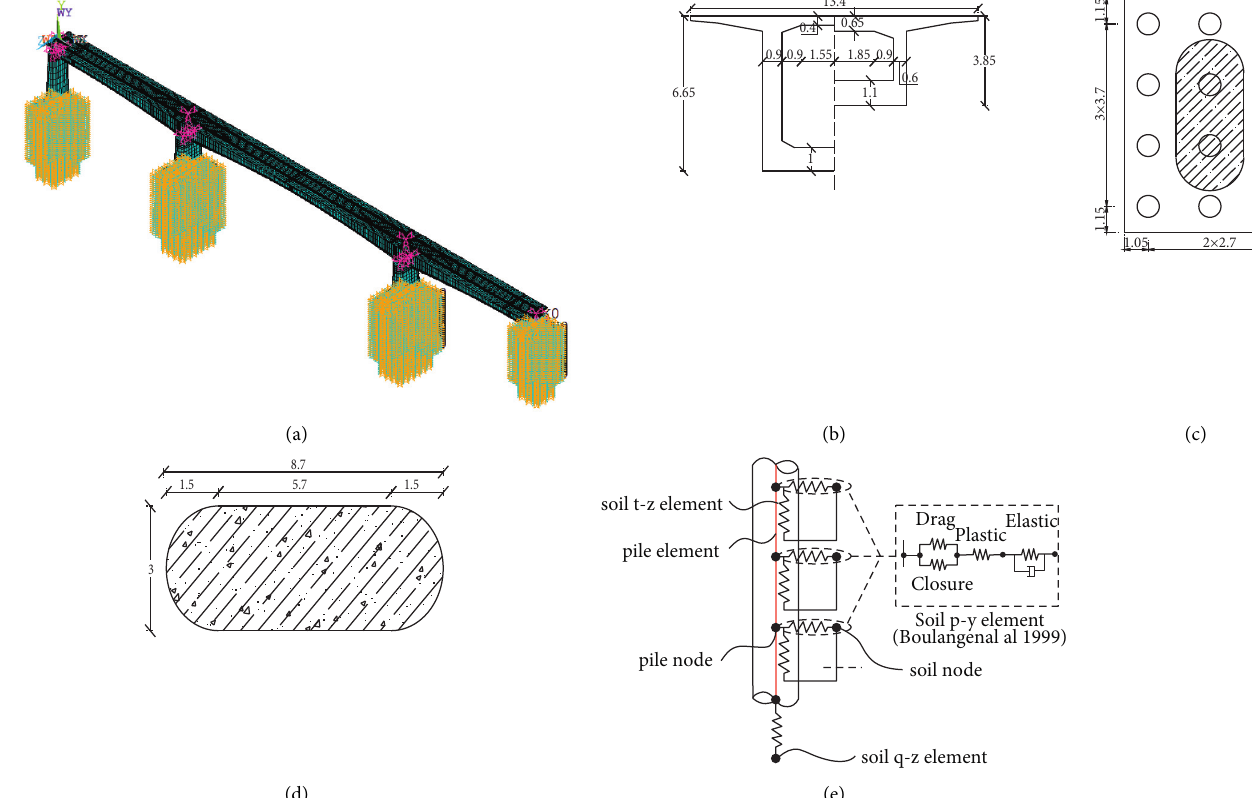
Figure 2: Typical bridge sections. (a) Bridge structure, (b) girder section, (c) bearing section, (d) pier section, and (e) pile-soil interaction